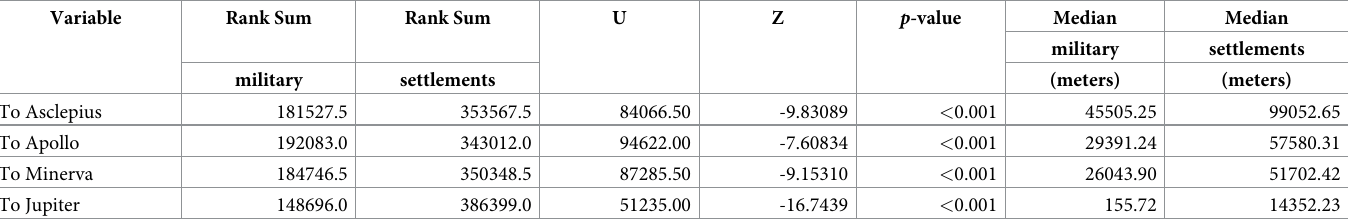
Table 1. Mann-Whitney U test results for distances from military positions and Roman settlements to their nearest place of worship of Asclepius, Apollo, Minerva, and Jupiter.